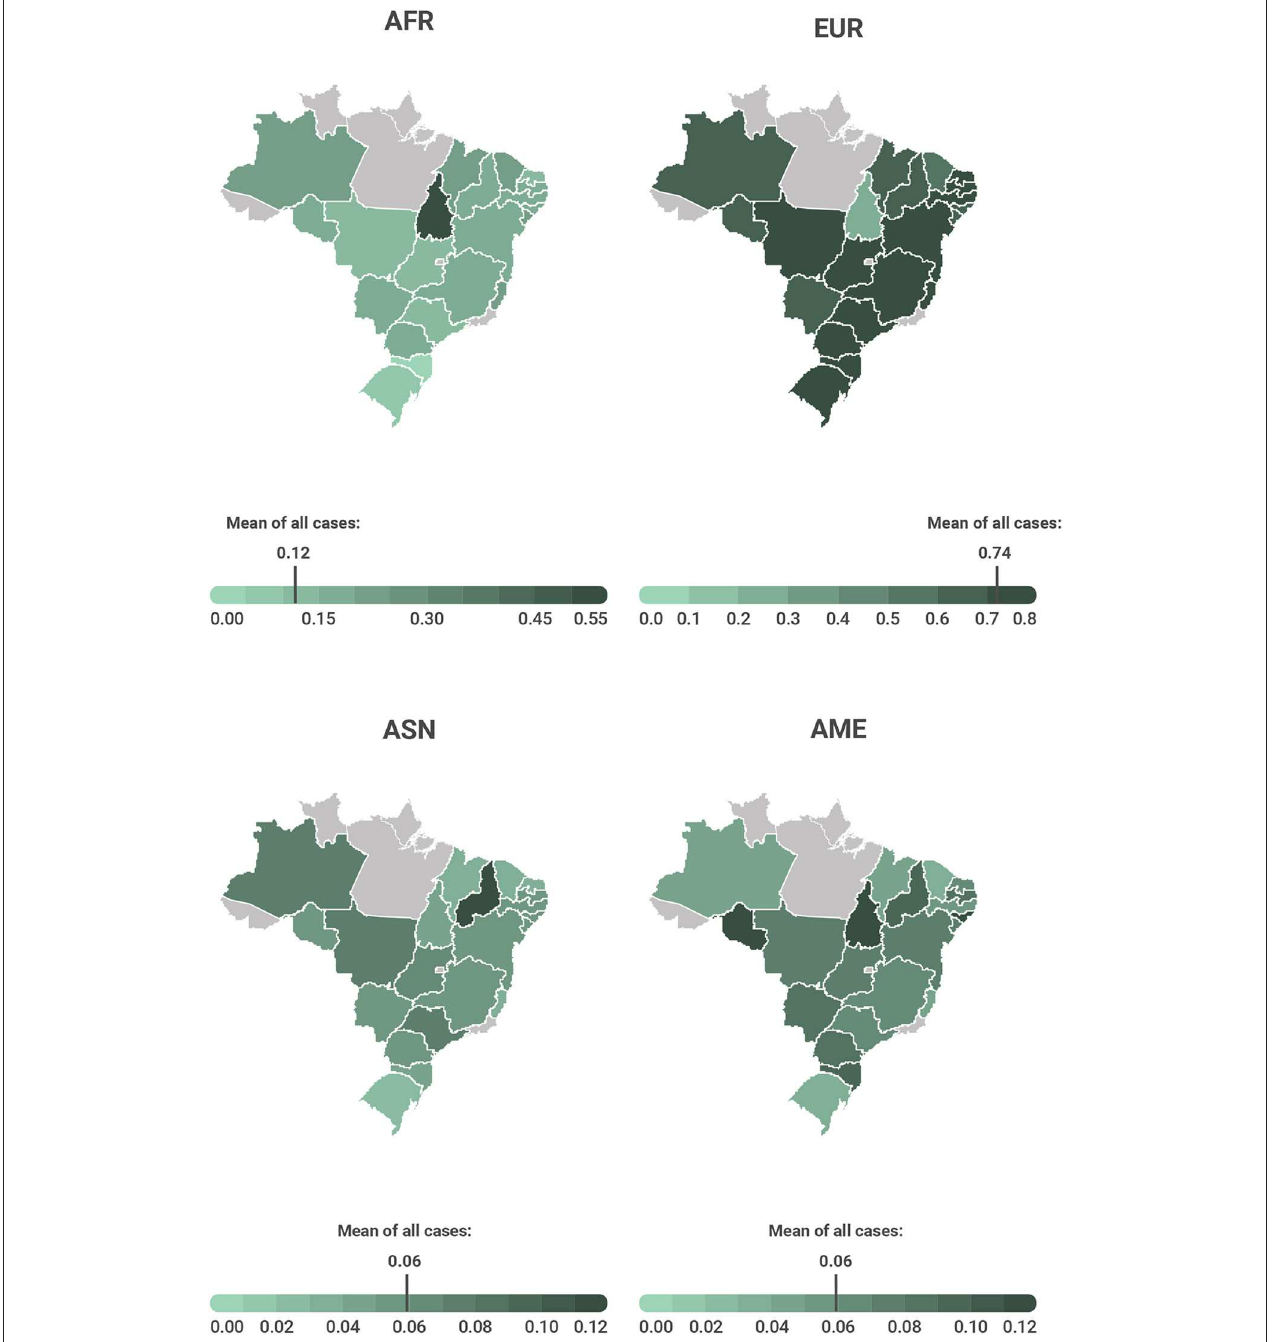
FIGURE 2 | Average of each genetic ancestry component according to the Brazilian state of origin. AFR- African; EUR- European; ASN- Asian; AME- Amerindian (Native American).